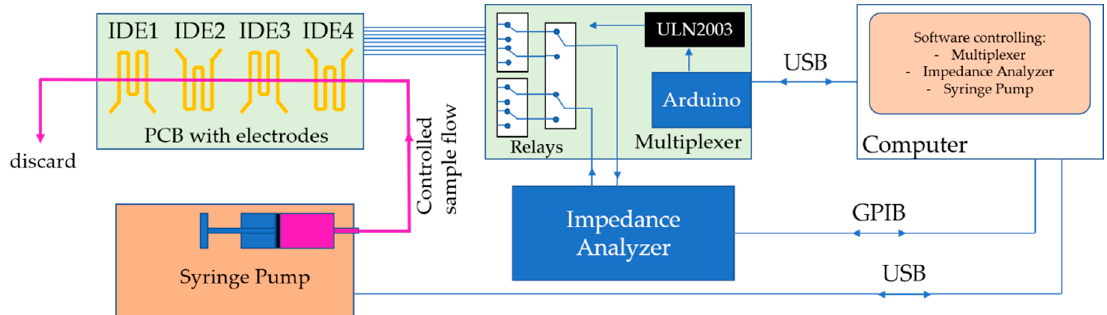
microchannel ( left ) connected to the digitally controlled analog multiplexing system ( right ).